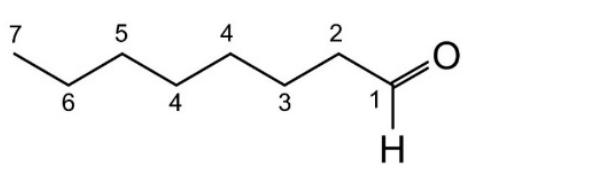
Figure 7. Differentiation of n-octanal carbon atoms detectable by T1 13 C NMR. Table 5. Octanal in p -Xylene-d 10 : T1 bulk and T1 ads resulting from analysis of the inversion recovery curves (Figures S4–S6) from 13 C NMR spectra in high-field (600 MHz).